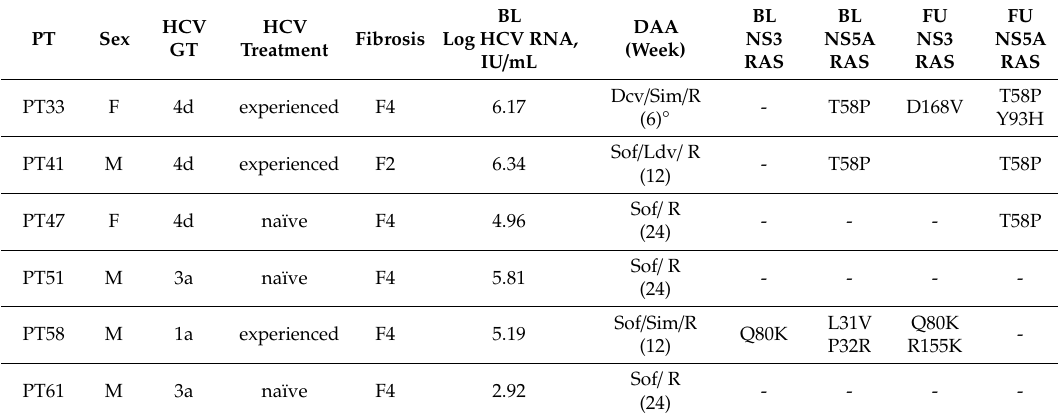
Table 3. RAS profile in 6 HIV-1 / HCV coinfected patients with no response to DAA